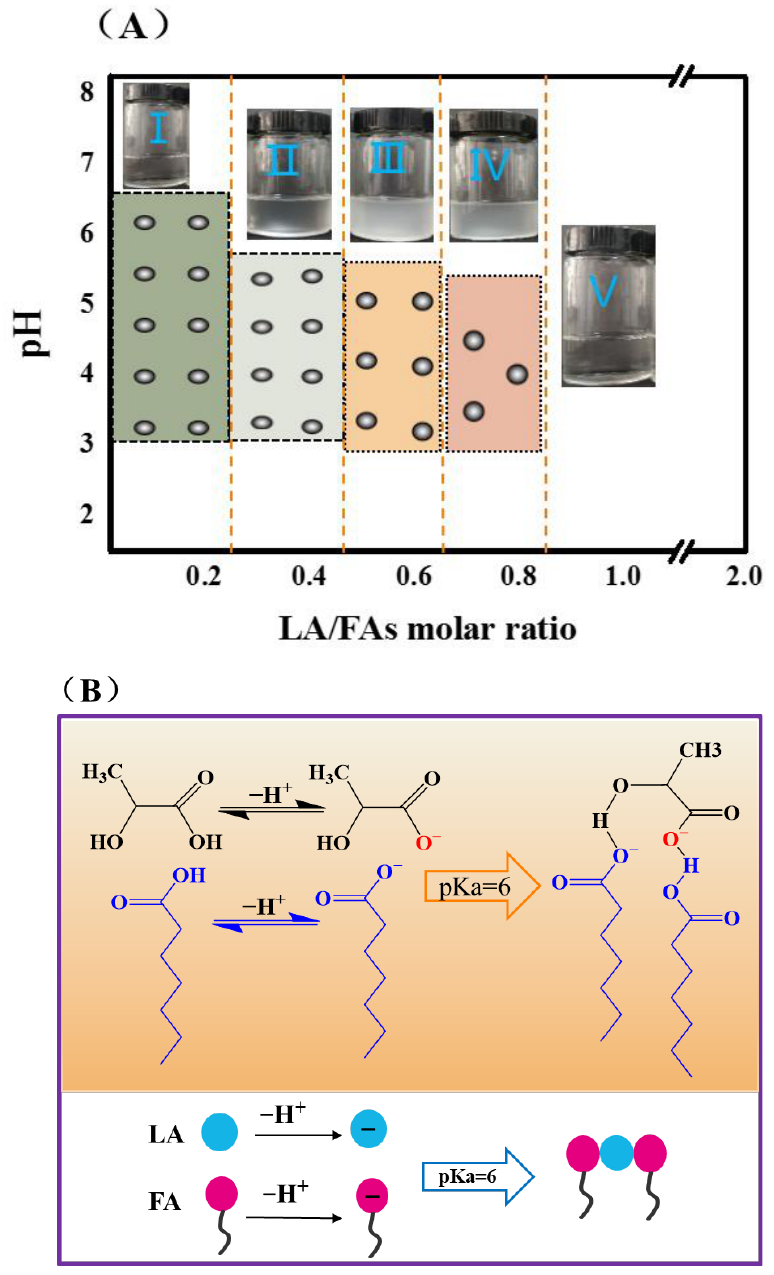
Figure 1. ( A ) The phase diagram of fatty acid vesicles was established as a function of pH and LA/FA molar ratio (R = LA/FA). ( B ) Expression of the vesicle formation mechanism. Lactic acid dissociates to form carboxyl group, which is connected to carboxylate ion of fatty acid through hydrogen bond under the charge interaction.